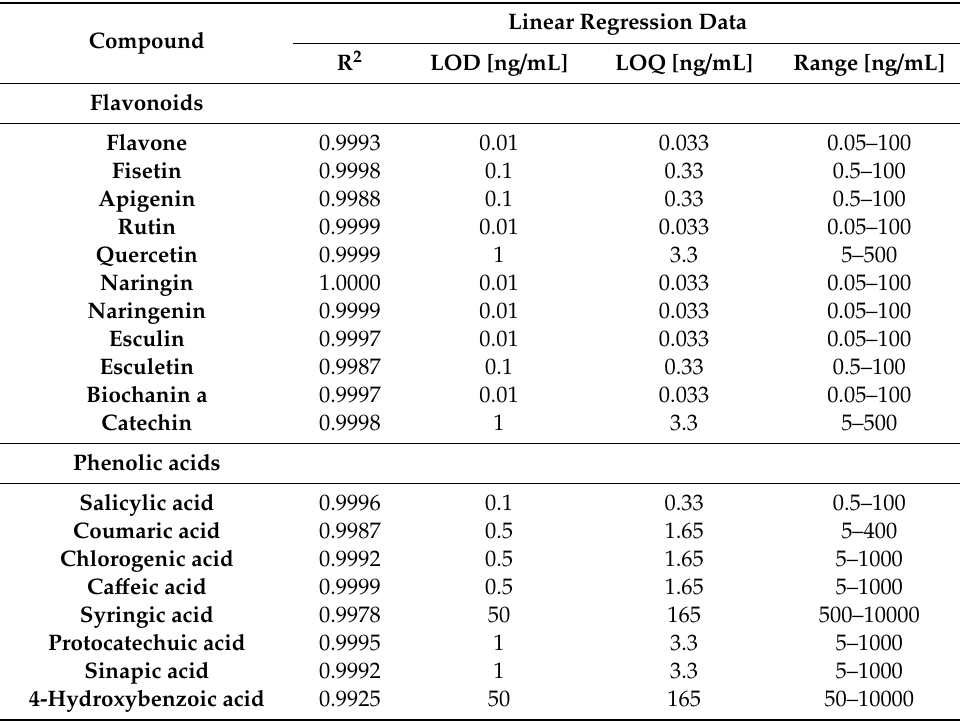
Table 5. Validation of the method in HPLC-MS /